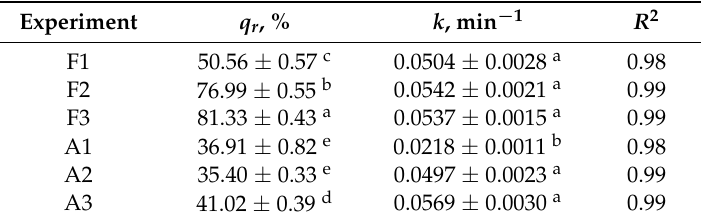
Table 3. Kinetic parameters and goodness of fit of the